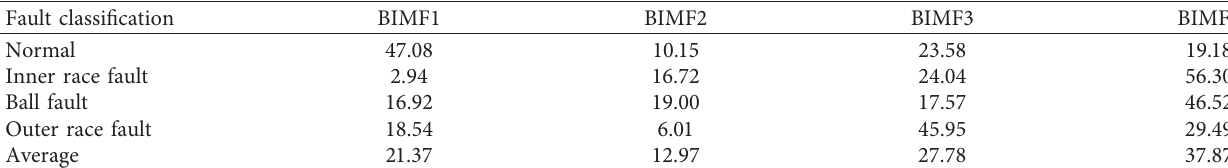
Table 3: Variance contribution rate of BIMF.